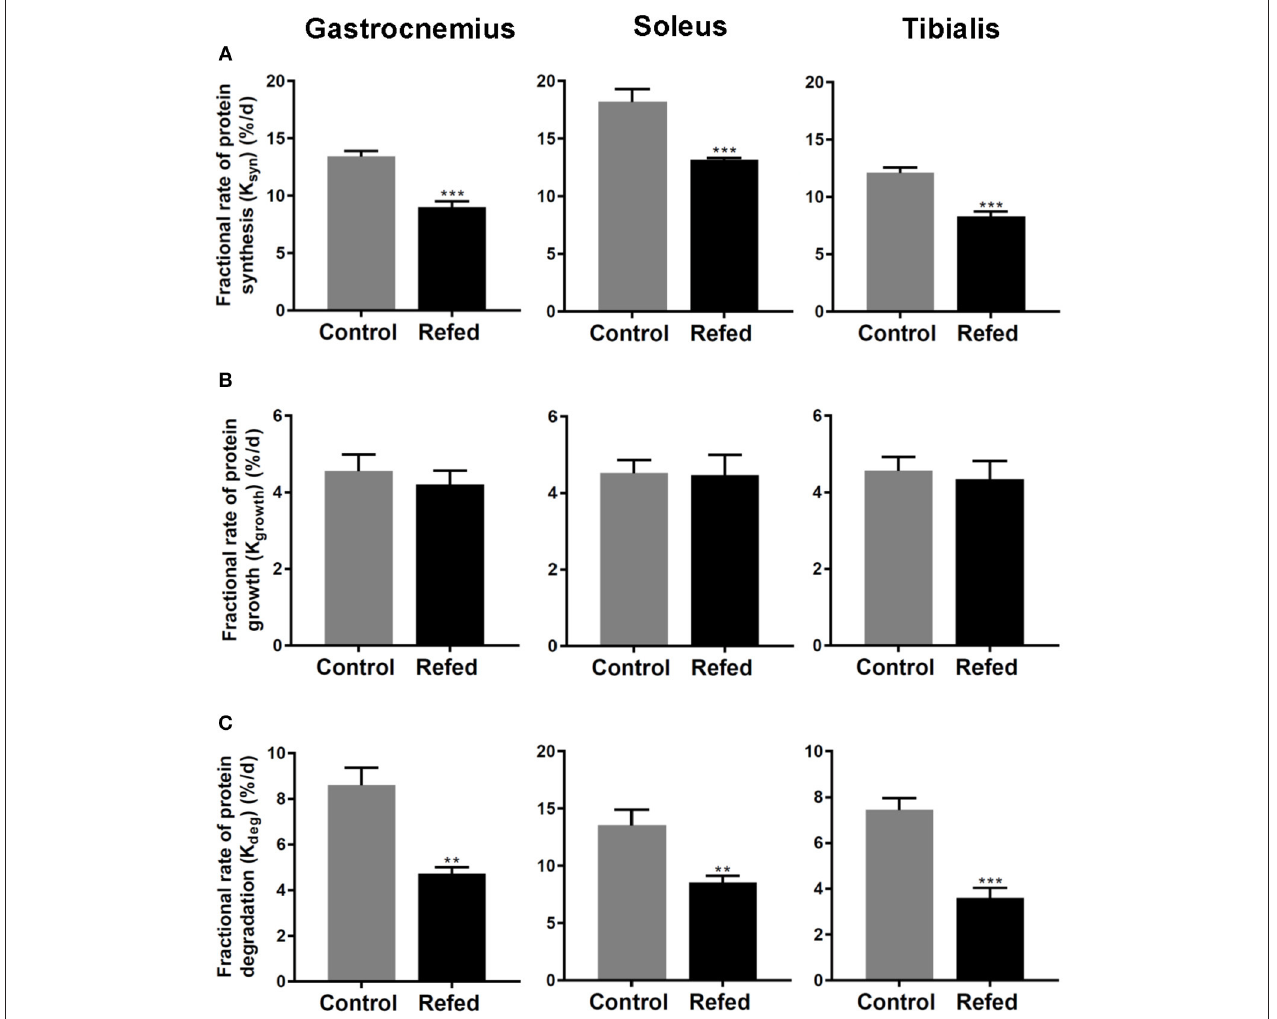
FIGURE 2 | Fractional rates of (A) protein synthesis (K syn ), (B) protein growth (K growth ), and (C) protein degradation (K deg ) in the Gastrocnemius, Soleus and Tibialis anterior muscles of rats after 7 days of refeeding in refed and control groups. The values are mean ± SE ( n = 6–7). Statistical significance of differences are indicated as follows: ** p < 0.01; *** p <